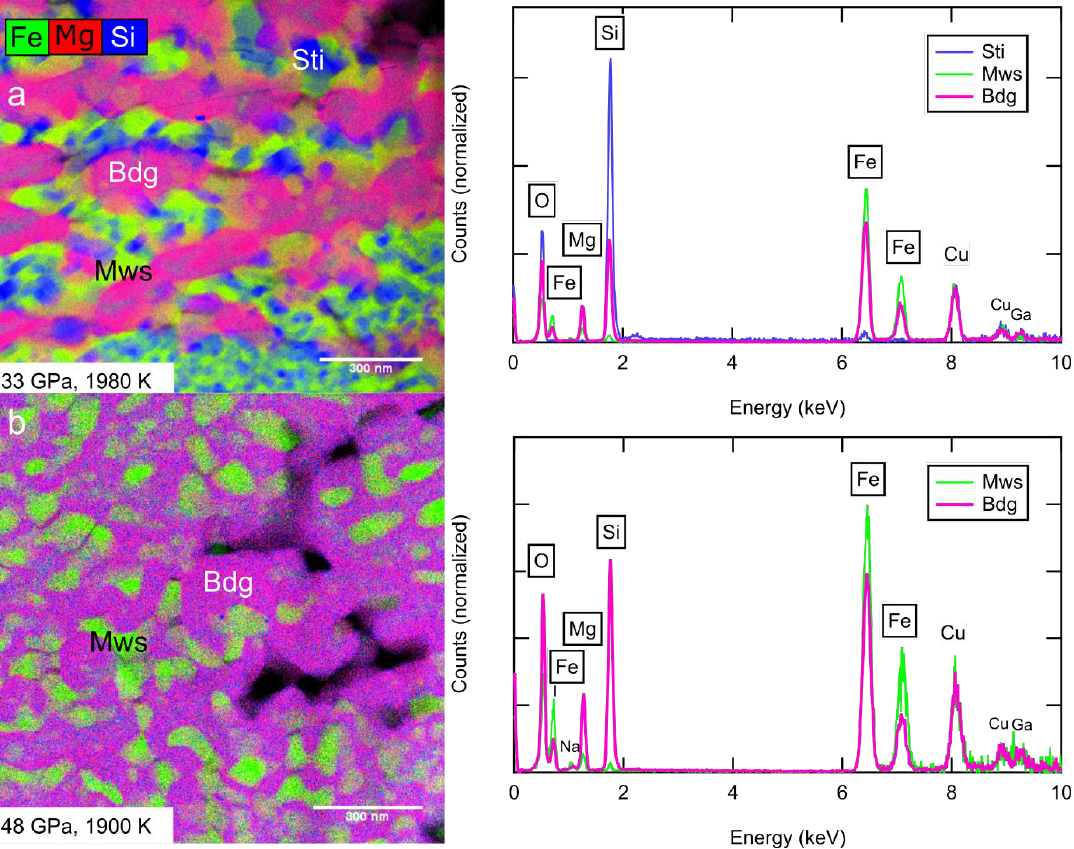
Figure 2. Energy-dispersive X-ray maps with Mg, Fe, and Si concentrations in red, green, and blue, respectively, and corresponding spectra obtained from selected grains for ( a ) Fa72 heated to 1980 K at 33 GPa and ( b ) Fa72 from 48 GPa. Bdg = bridgmanite, Mws = magnesiowüstite, Sti = stishovite. Cu signal is from the TEM grid, and minor Ga remains from ion milling.